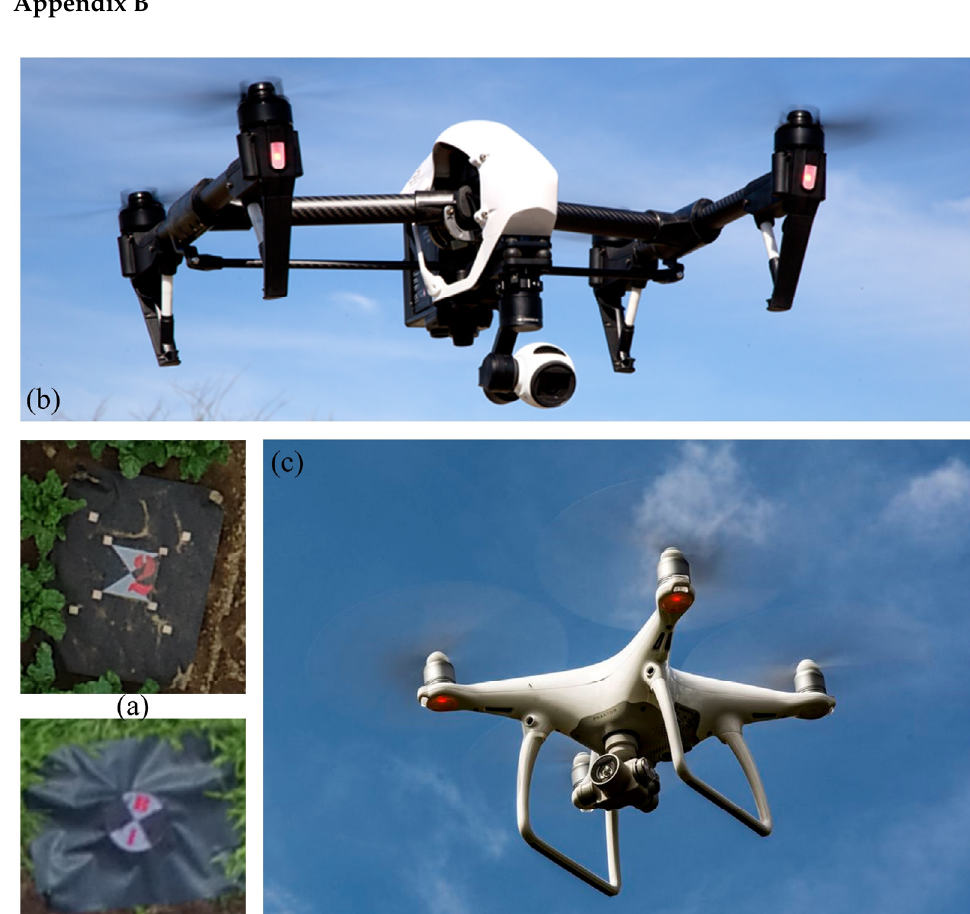
Figure A2. Ground control point (GCP) and unmanned aerial vehicle (UAV) systems used in the field. ( a ) Square and circle GCPs, ( b ) DJI Inspire 1, and ( c ) DJI Phantom 4 (V1 and V2 share a similar appearance).